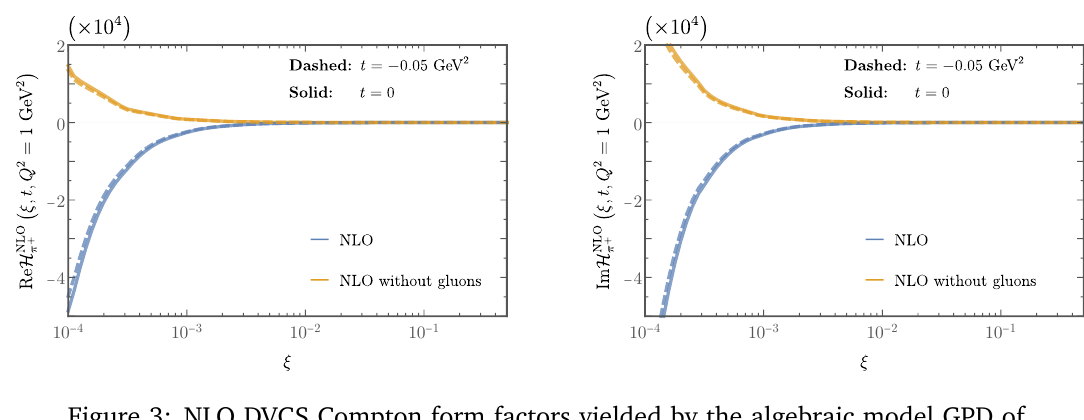
Figure 3: NLO DVCS Compton form factors yielded by the algebraic model GPD of = 1 GeV 2 (blue-line). Yellow plots correspond to Fig.2 at a factorisation scale of µ 2 F the NLO calculation with the input gluon distribution set to